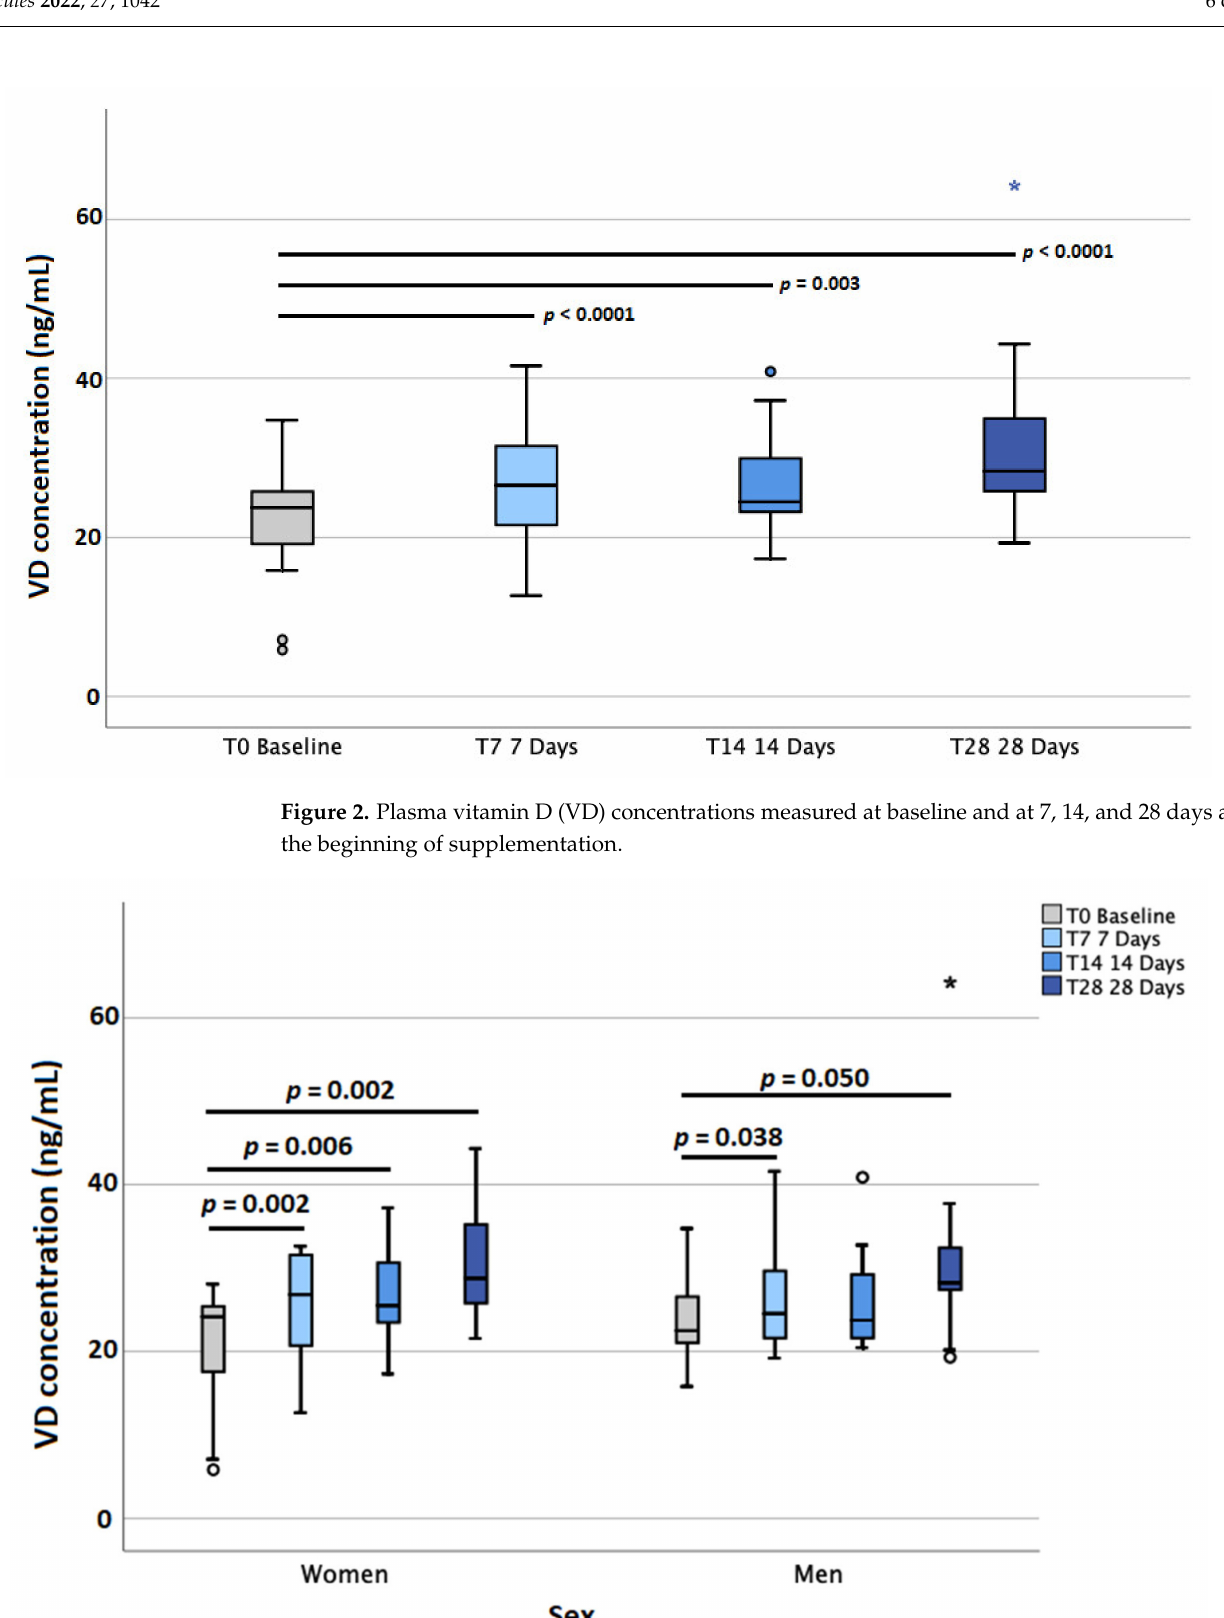
Figure 3. Plasma vitamin D (VD) monthly increase according to sex. No correlations were found between VD increases and age or UV exposure,